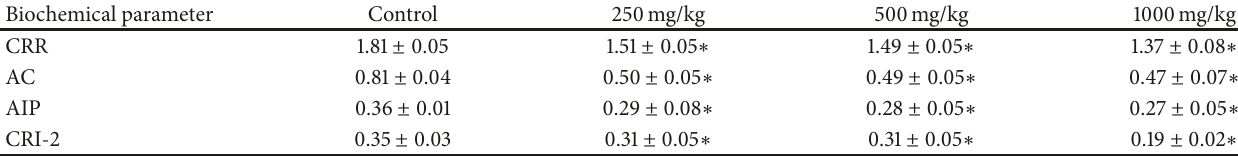
Table 7: The effects of different concentrations of pomelo methanolic extracts on atherogenic indices.